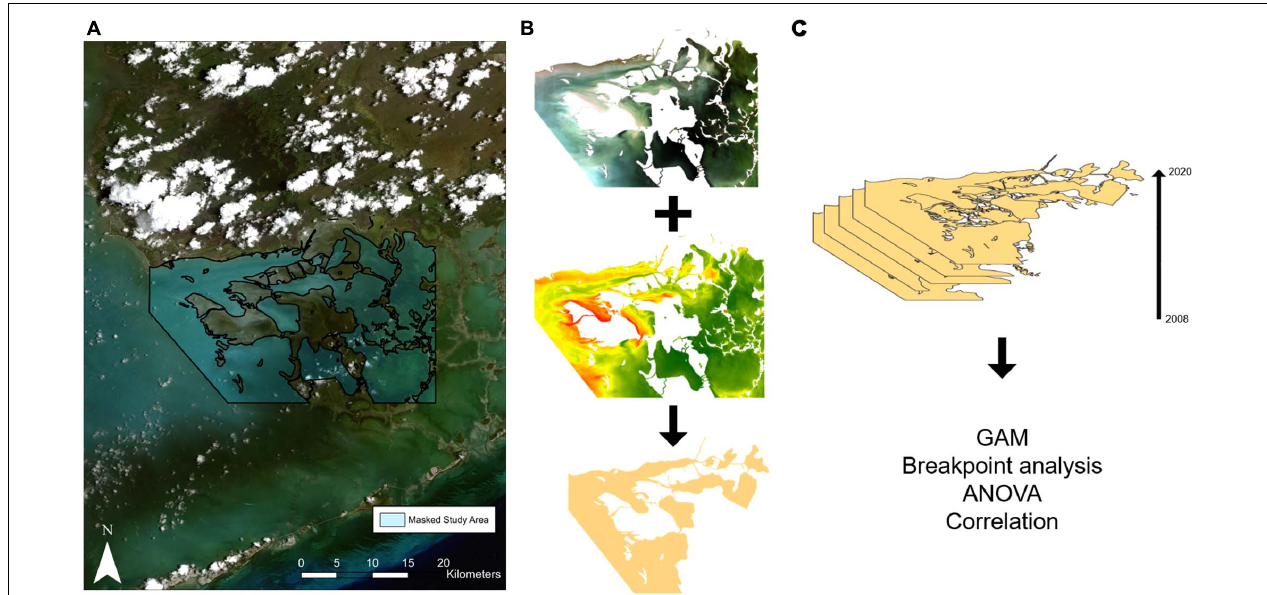
FIGURE 3 | Illustration of the methods employed in this study. LandSat images were loaded into Google Earth Engine and (A) masked to remove clouds, land, and shallow banks. (B) The masked satellite images and an approximate suspended sediment concentration (SSC) map were downloaded used for sediment plume delineation. (C) A total of 24 images were delineated from 2008 to 2020, GAMs were used to model the expansion of the plume, breakpoint analysis was used to determine a significant change in sediment plume size while ANOVAs and correlation analysis were used to determine the impact of the sediment plume on seagrass